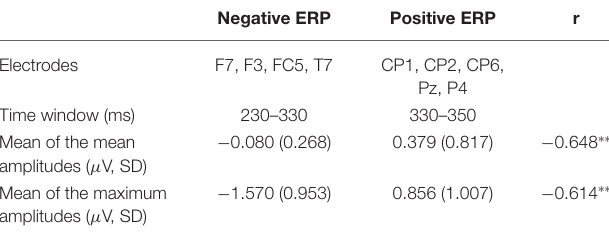
TABLE 2 | Means of the mean amplitudes and maximum amplitudes of the ERPs for the fifth phrase in Distant with Quantifier First, with r as their correlation coefficients.